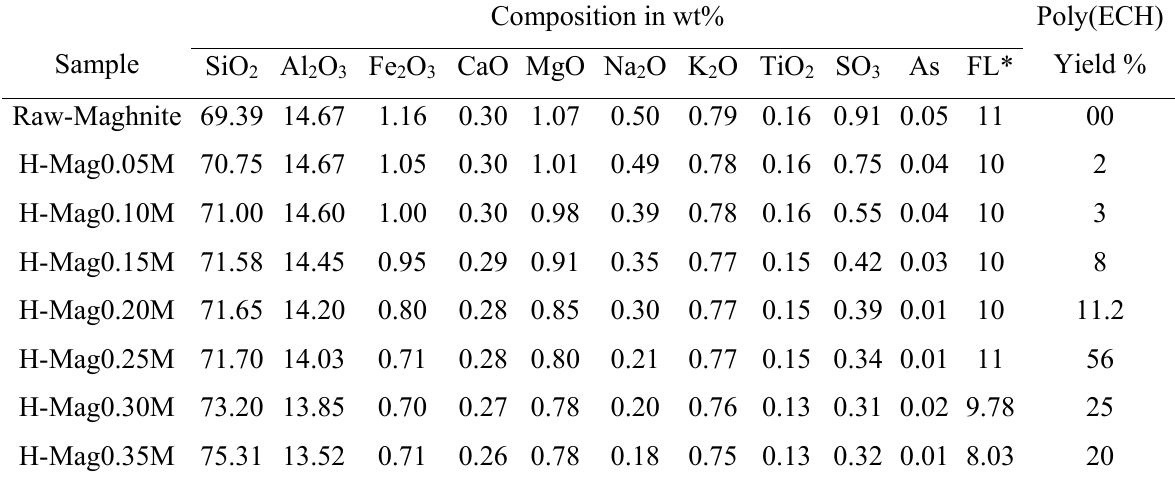
Table1. Elementary compositions of Protons exchanged samples “H-Maghnite”